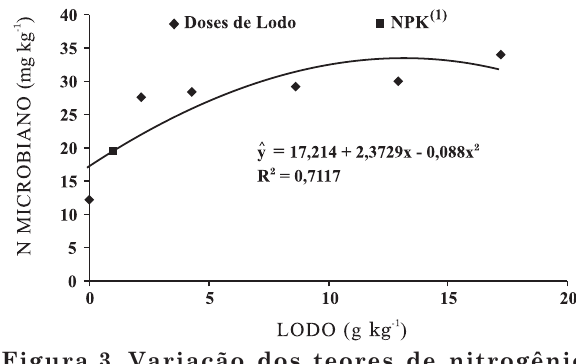
Figura 3. Variação dos teores de nitrogênio microbiano no solo em função da aplicação de lodo anaeróbio da estação de tratamento de efluentes da parboilização do arroz. * Significativo a 5 %. (1) Tratamento NPK incluído como referência fora da análise de